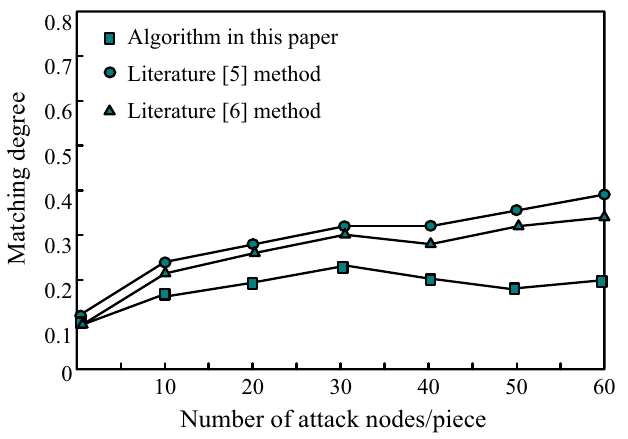
Figure 2. Comparison results of attack results.